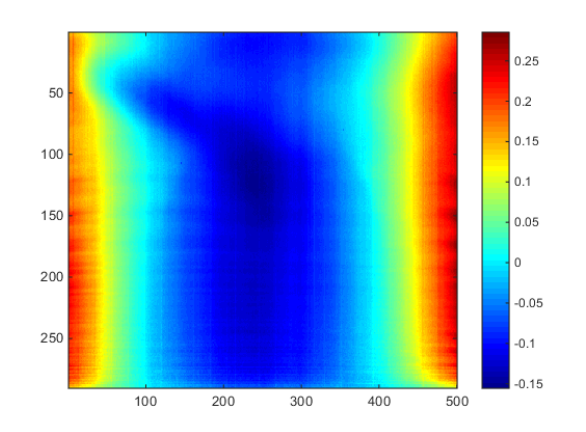
Figure 2: Relative error in radiometric calibration coefficients af- ter whitening.